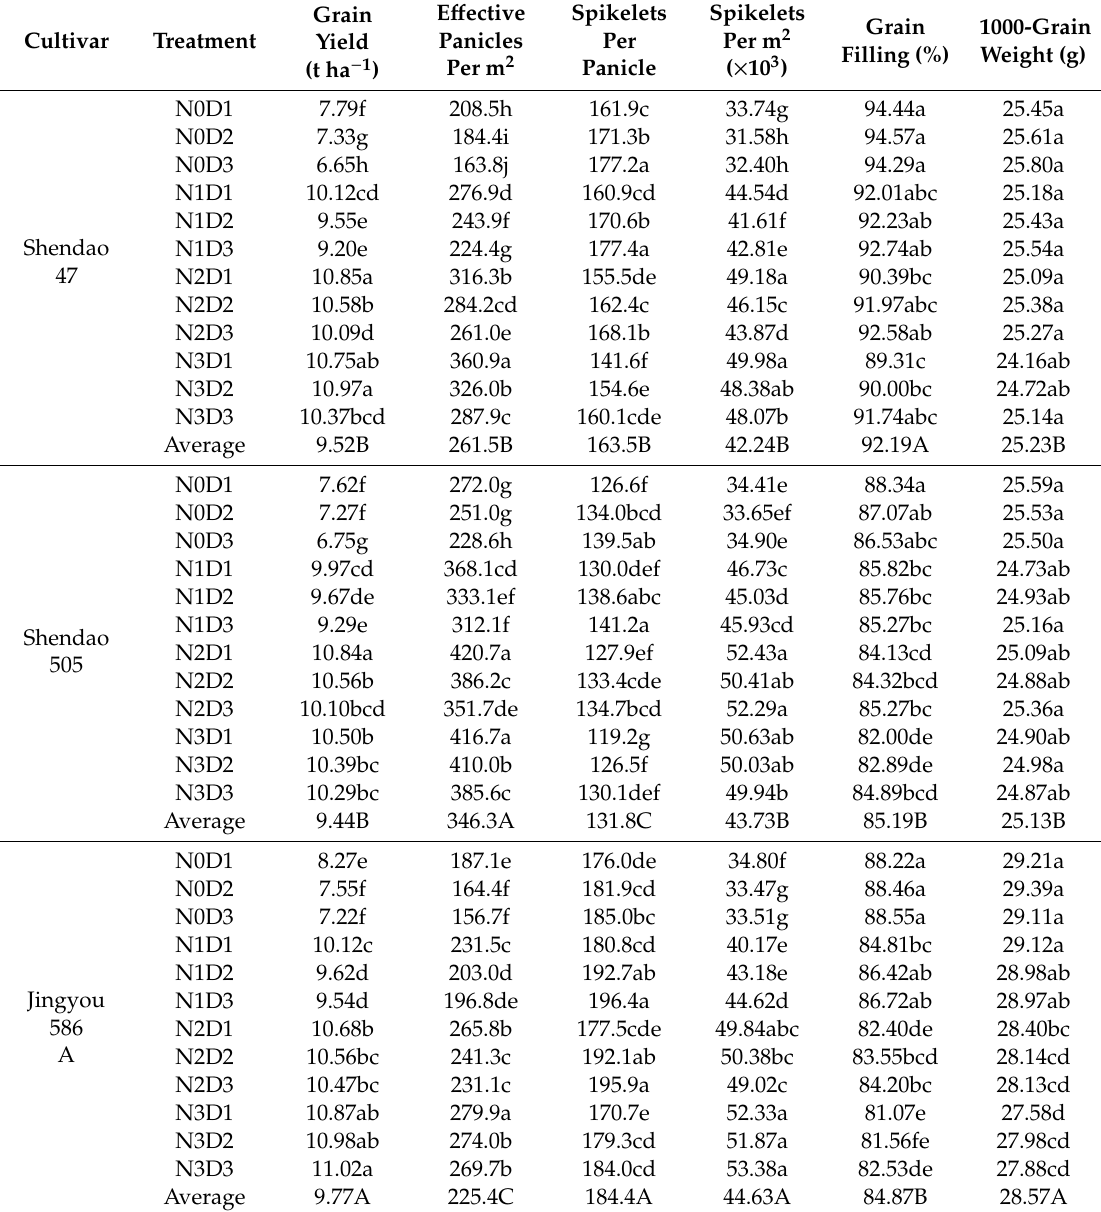
Table 3. Grain yield and yield components of three cultivars under di ff erent nitrogen application rates and transplanting